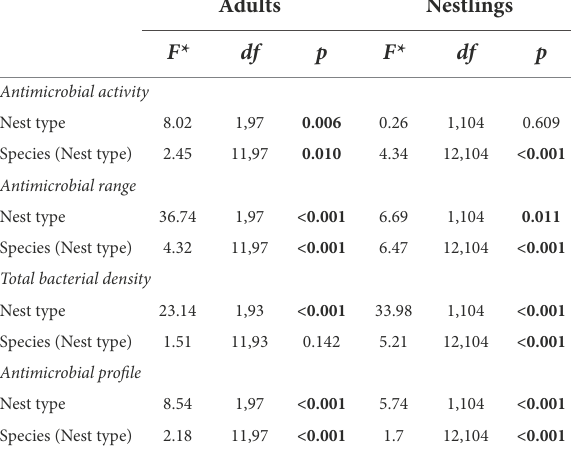
TABLE 3 Results of nested General Linear Models (GLM) and PERMANOVAs exploring the effects of nest type (hole vs. non-hole) and species identity (nested withing nest type) on the antimicrobial activity (average values of the width of antagonistic halos when tested against each of the nine indicator bacteria), antimicrobial range (Shannon index of the antimicrobial activity), bacterial density and the antimicrobial profile in separated models for each of the dependent variable, and for adults and nestlings.